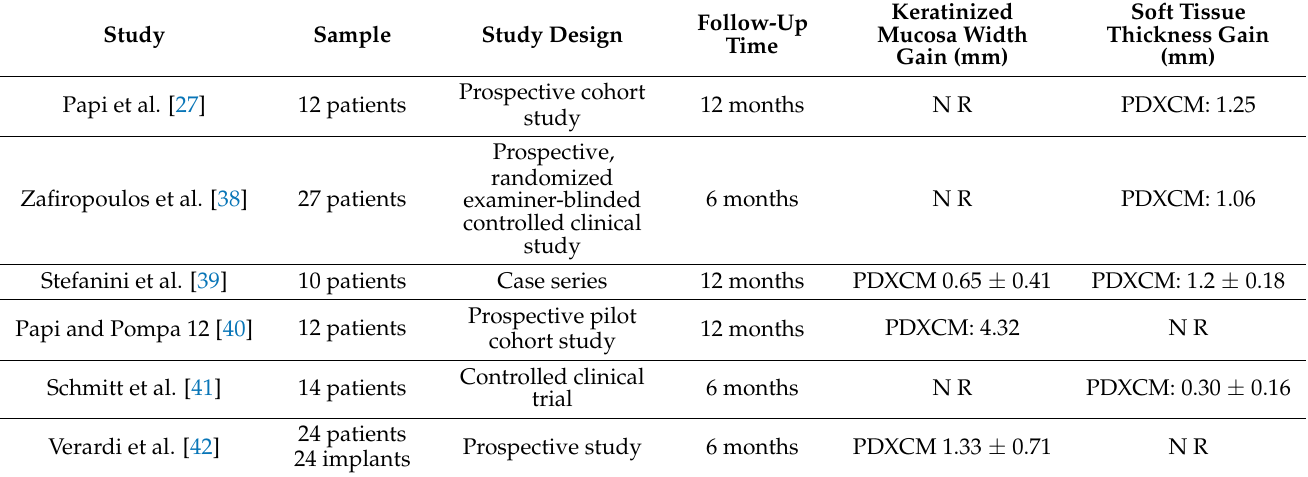
Table 5. General overview of the results reported by selected studies in which PDXCM was